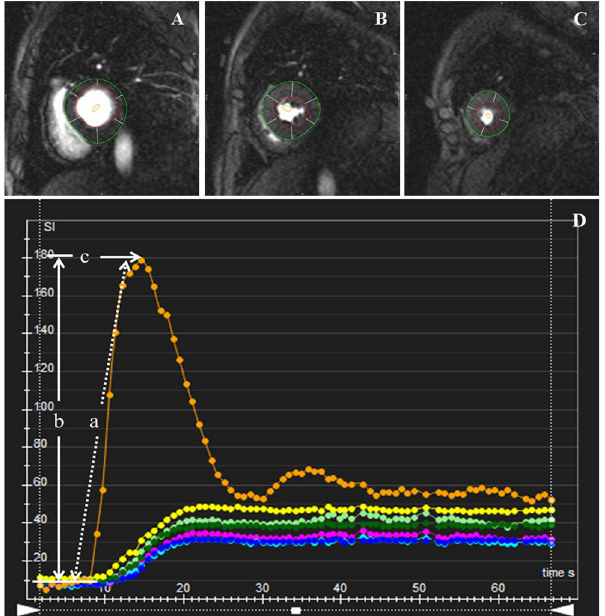
Figure 3. AHA bull’s eye model according to standard segmentation for regional perfusion analysis. Based on this model, segmentation of the LV on myocardial first-pass perfusion images included the following: ( A) Basal segments; ( B ) Mid-ventricular segments; and ( C ) Apical segments. The first-pass perfusion values including upslope (a), MaxSI (b), and TTM (c) were automatically obtained by signal intensity-time curve derived from myocardial perfusion images ( D ). Abbreviations: MaxSI, Max signal intensity. TTM, time to max signal